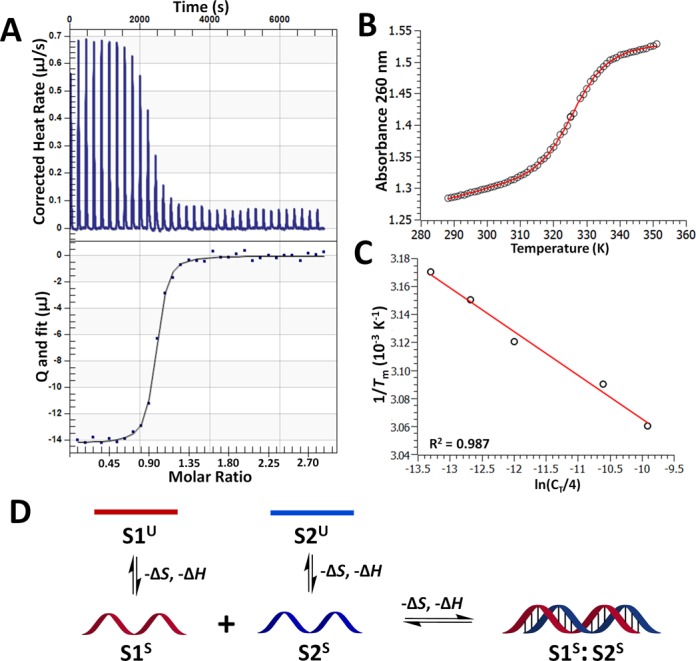
Experimental and mechanistic thermodynamic evaluations of duplex formation. (A) Representative ITC data measuring the thermodynamics of RNA duplex formation of s2U:Uc. The s2U-containing ssRNA (100 μM) was titrated into a solution containing its complement (10 μM) in 200 mM NaHEPES, pH 7.5, 100 mM NaCl at 25°C. Top: Raw curve of power versus time. Bottom: Fit of integrated peak areas (heat released per injection) yielding the thermodynamic parameters presented in Table 1. Isotherms for the remaining duplexes appear in Supplementary Figure S1; (B) Melting curve (black circles) collected during the thermal denaturation of 200 μM U:A in 100 mM NaCl and 200 mM NaHEPES, pH 7.5 and the double-baseline, two-state fitted model (red line). Melting curves for the remaining duplexes appear in Supplementary Figure S2; (C) Linear least-squared fit (red line) of a van ′t Hoff plot of inverse melting temperatures (Tm−1) collected from optical melts at different total oligonucleotide concentrations (CT) of U:A. Additional fits appear in Supplementary Figure S3; (D) Mechanistic scheme depicting the thermodynamic steps of duplex formation, beginning with the transition of single strands from an unstacked (S1U and S2U) to a stacked (S1S and S2S) state before the formation of the duplex (S1S:S2S). Both the stacking of the single strands and the duplex formation steps are expected to result in the release of heat and a negative change in entropy.